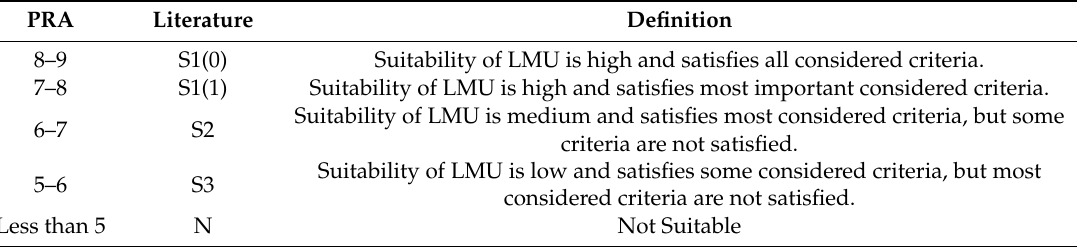
Table 6. Scale for Suitability Index ( S i ) for Land